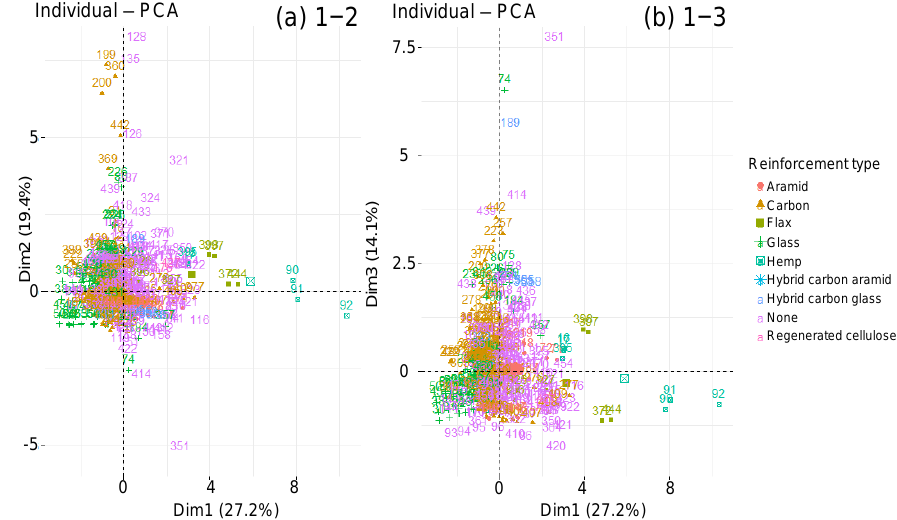
Figure 12. Graphs of individuals on planes ( a ) 1–2 and ( b ) 1–3 of the global PCA, according to reinforcement type.